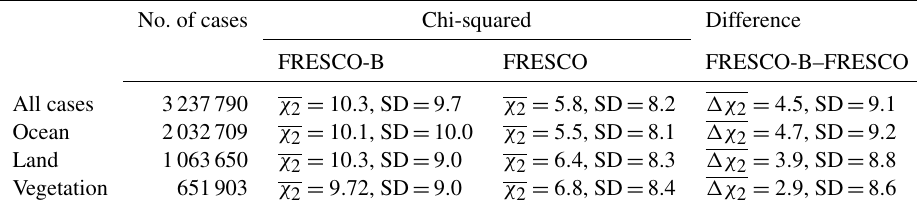
Table 5. Mean chi-squared and standard deviations for FRESCO-B and FRESCO, as well as the mean difference between FRESCO-B and FRESCO, for GOME-2B measurements in July 2014 over different surfaces. The vegetation category is a subpart of the land category.